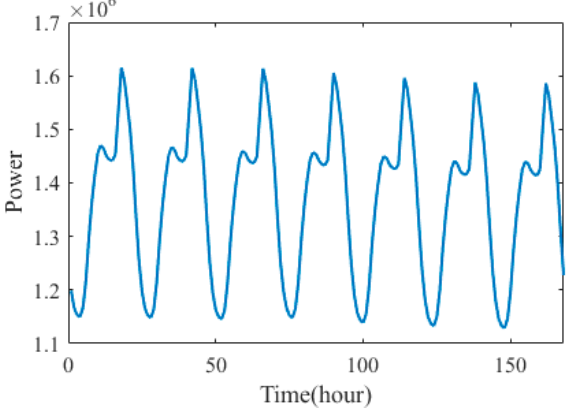
Figure 2. The representation of the power demand.